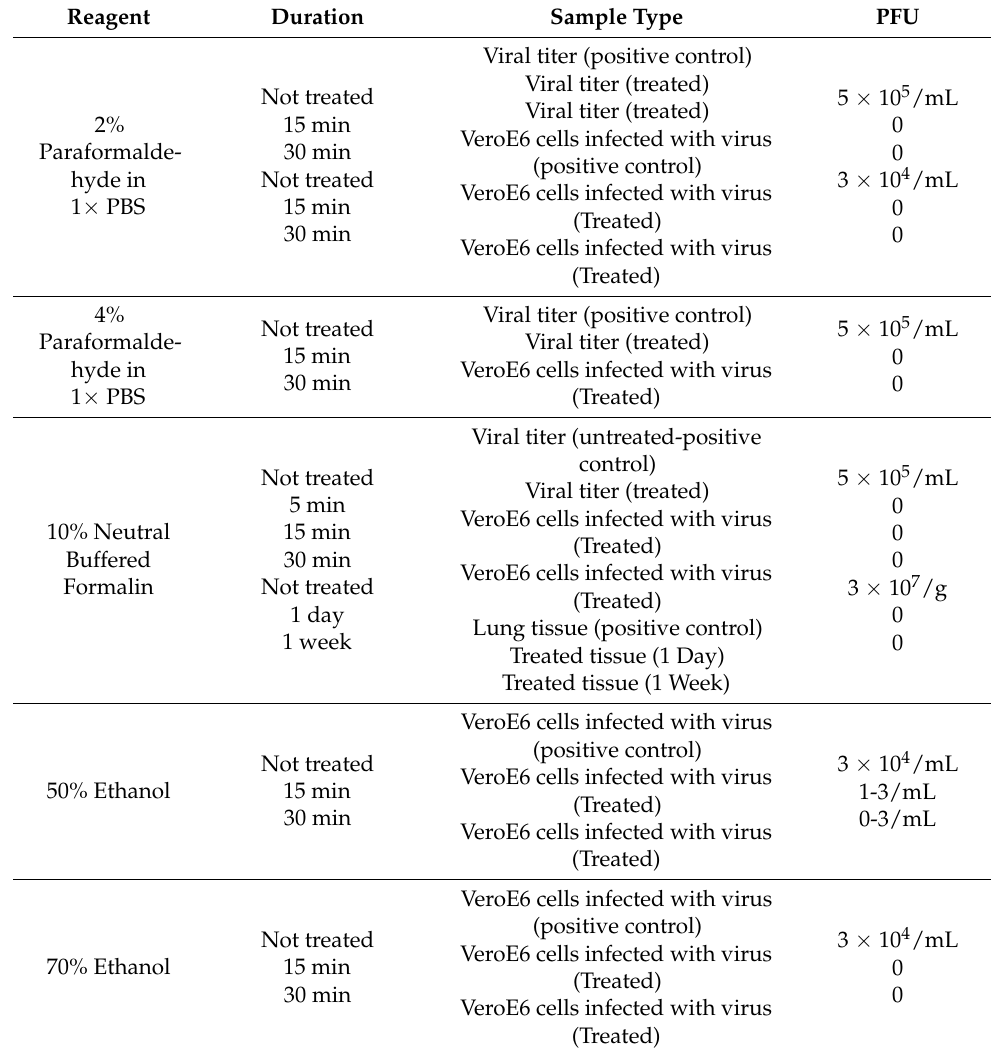
Table 2. Efficiency of standard fixatives in eliminating SARS-CoV-2 from various sample